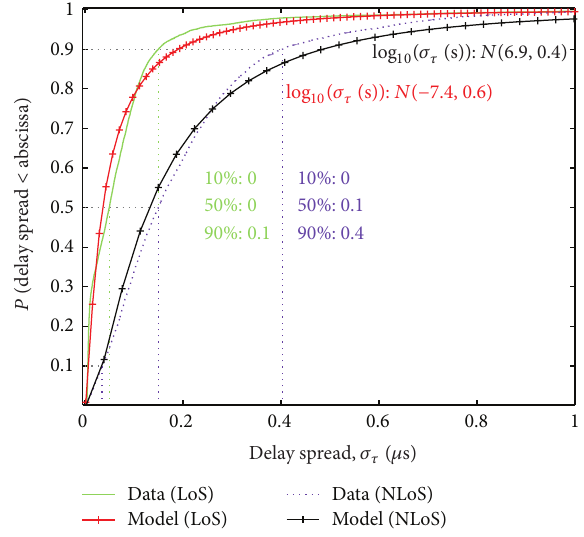
Figure 6: Distributions of delay spreads in Dresden